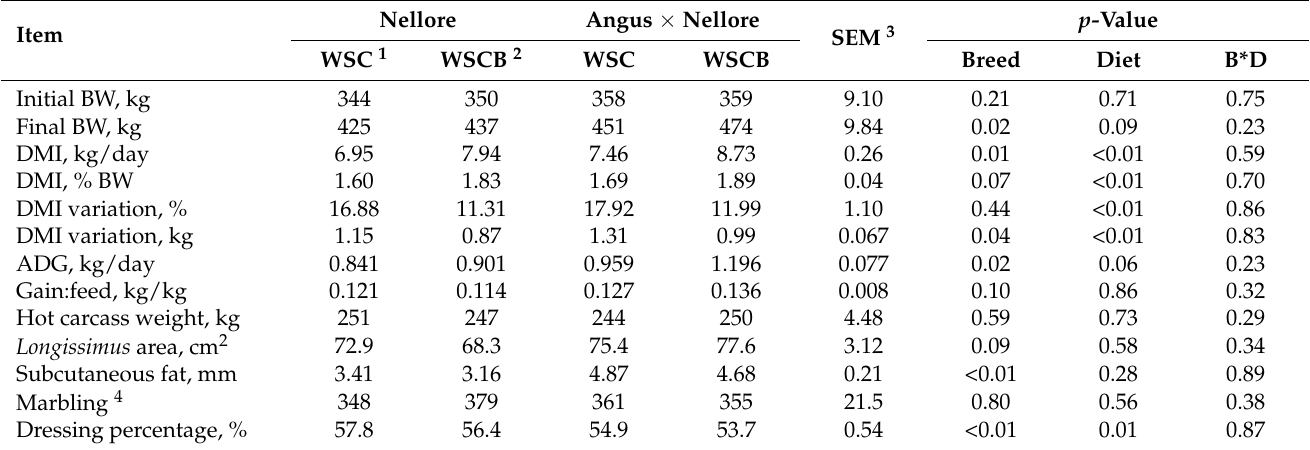
Table 2. Performance and carcass traits of Nellore and Angus × Nellore steers fed the whole shelled corn diet (WSC) or the whole shelled corn with sugarcane bagasse diet (WSCB) for 96 days of